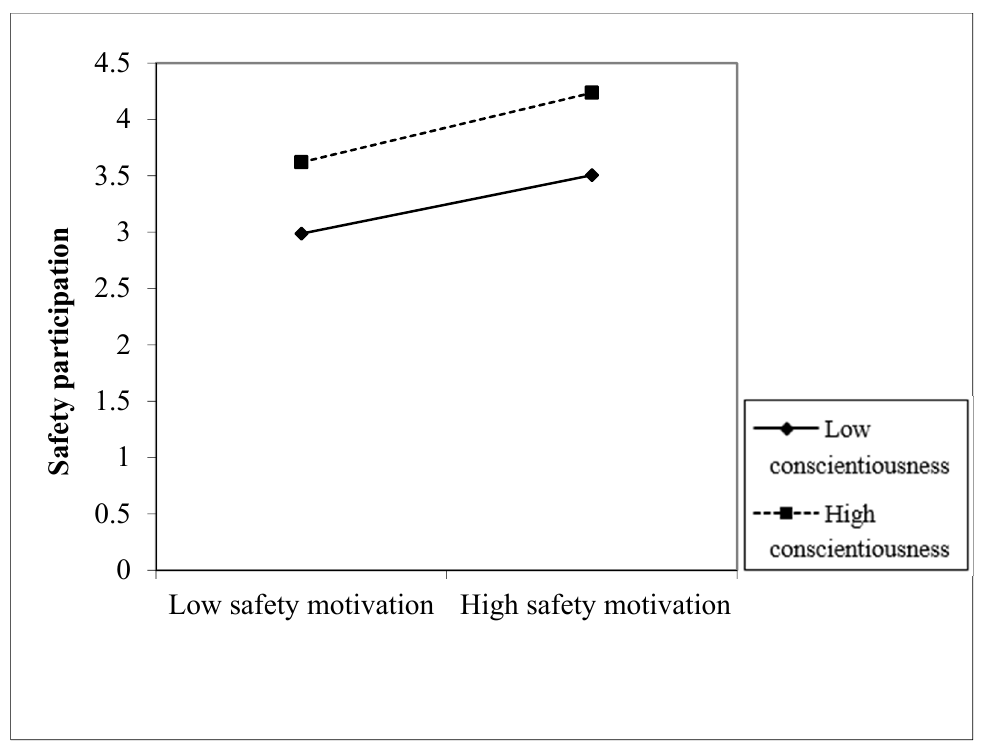
Figure 3. Interaction between safety motivation and conscientiousness on safety participation.